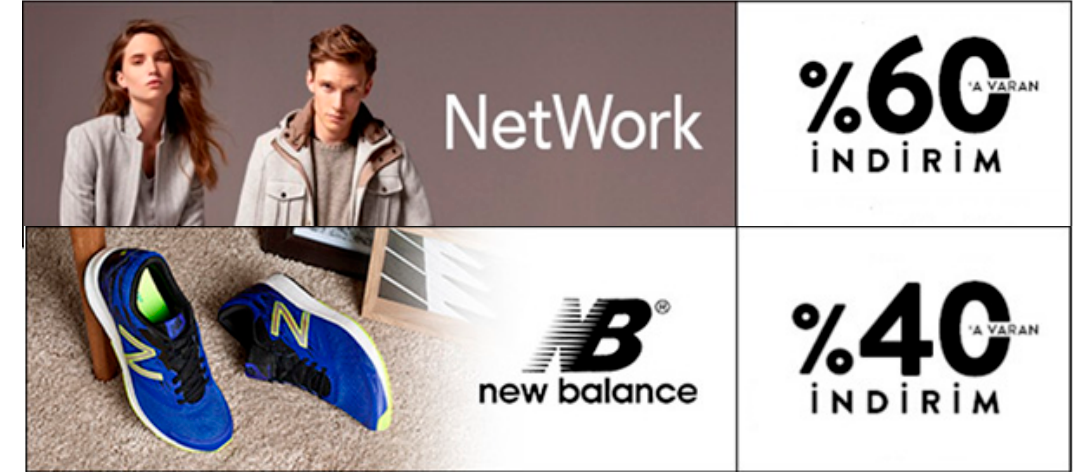
Figure A3. The banner ads numbered 3a ( above ) and 3b ( below ).